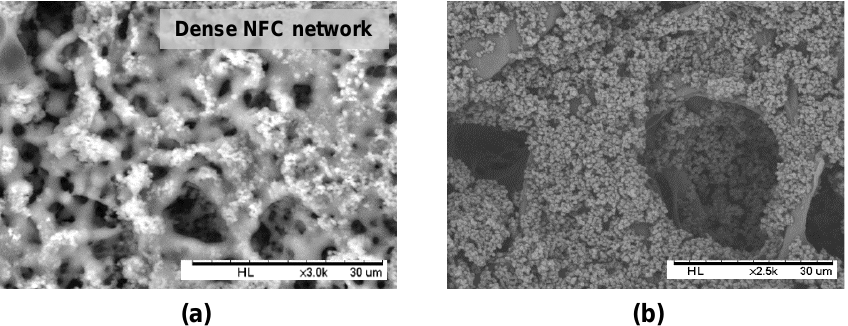
Figure 8. Scanning electron micrographs of filter paper dip-coated with the PHB-SP/NFC suspension having 7 wt % NFC, showing: ( a ) a dense NFC network retaining PHB-SP, when placed under strong X-rays for 5 min; and ( b ) retention of PHB-SP over the single fiber of paper after diluting the coating suspension (added 4 mL distilled